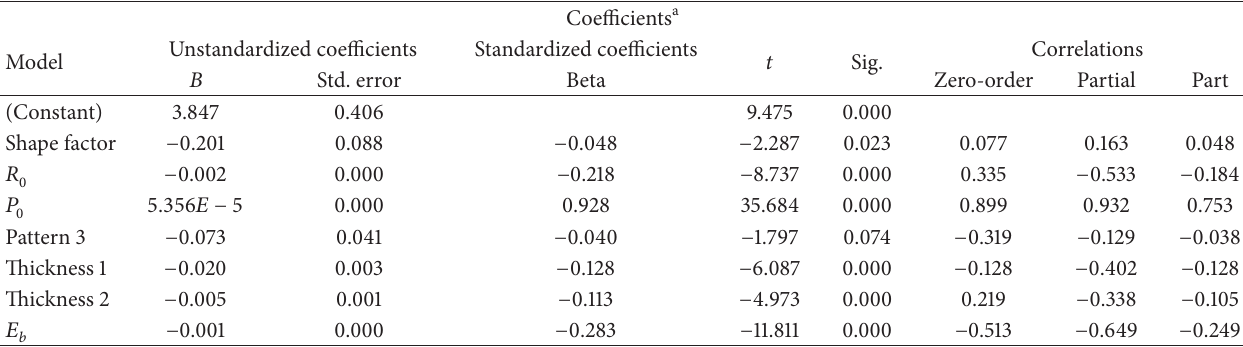
ℎ 1 is block thickness (mm), = 1 for herringbone pattern and 𝑝 𝑝 ℎ bone pattern, and 𝐸 𝑏 is elastic modulus of base